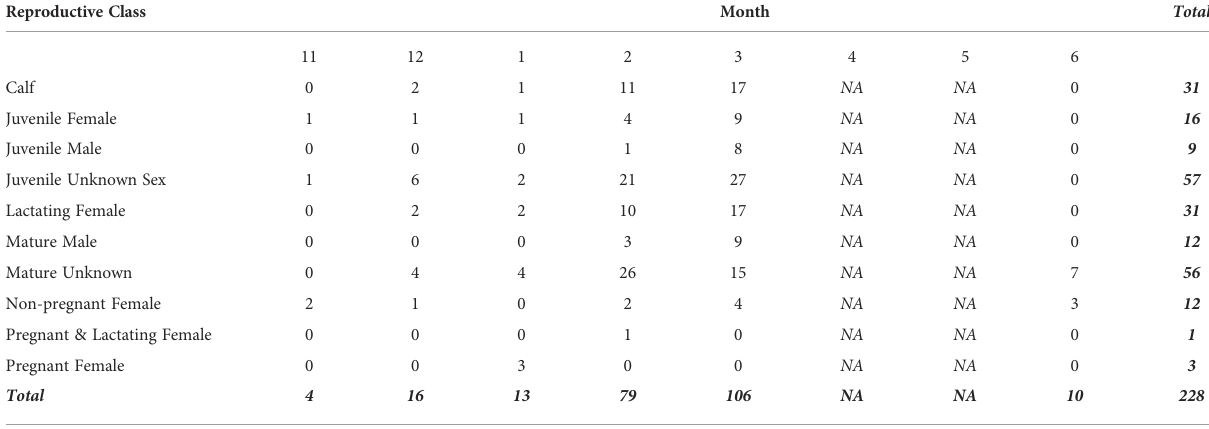
NA, not applicable. Column totals shown in